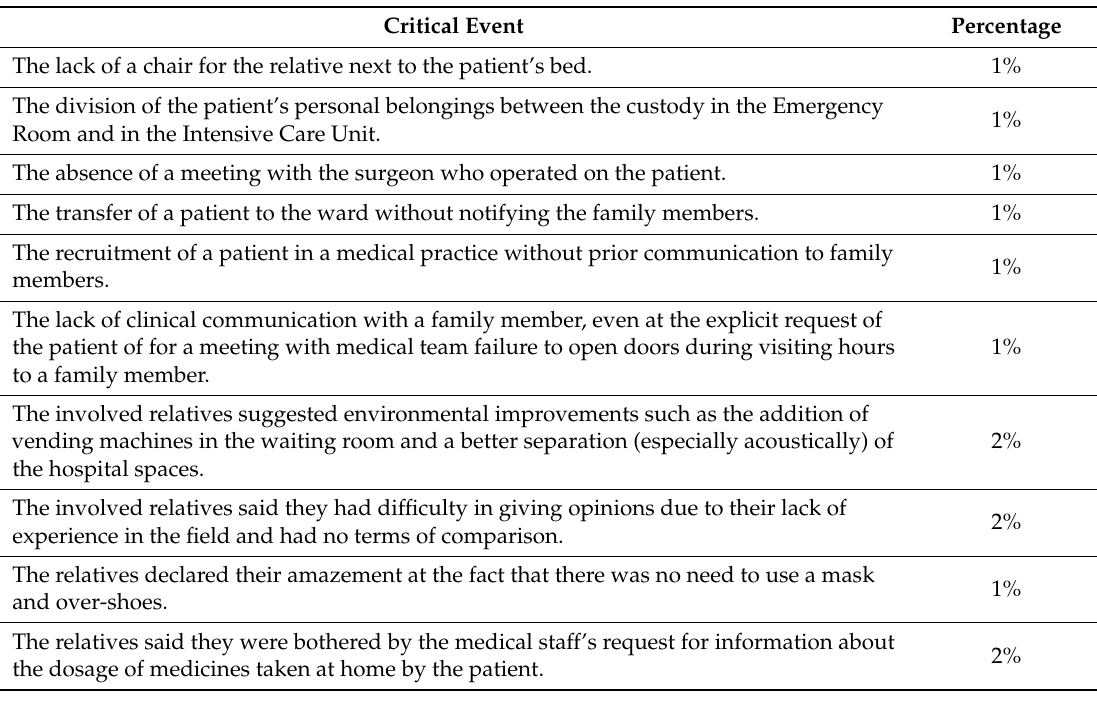
Table 4. Critical event